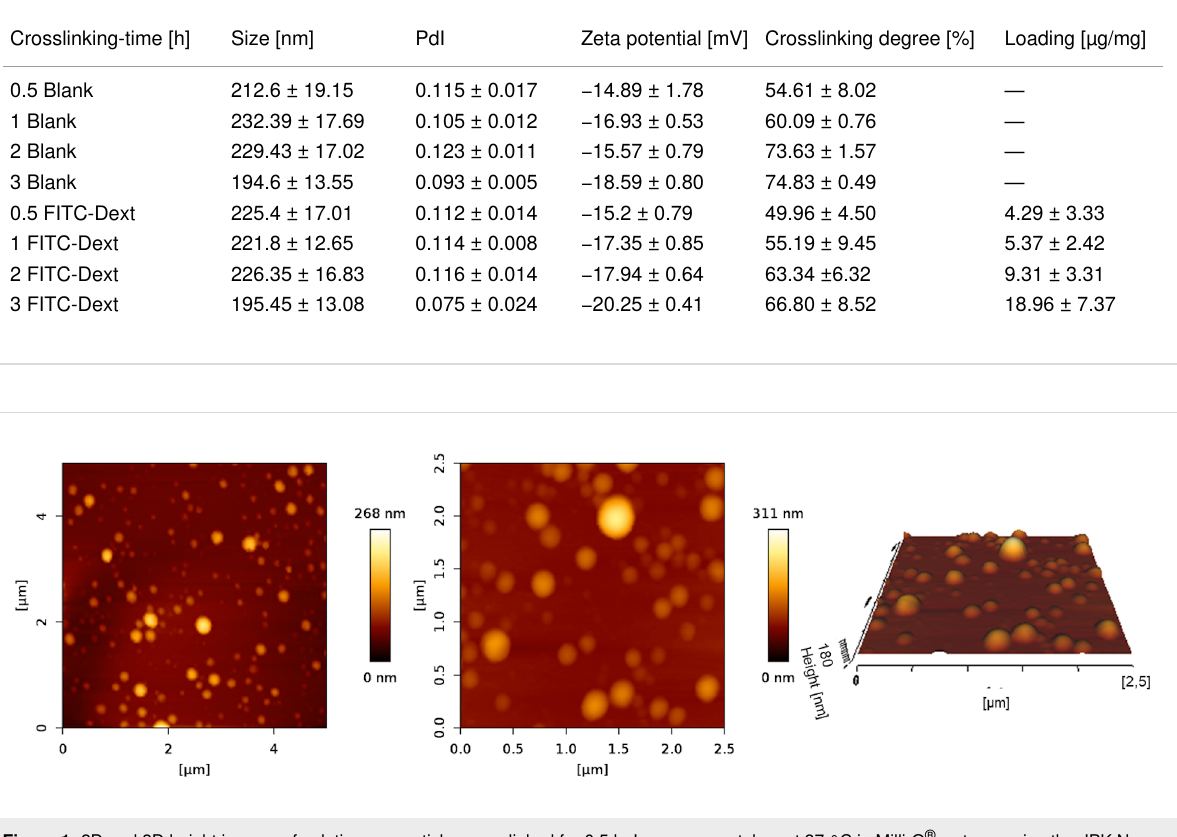
Figure 1: 2D and 3D height images of gelatin nanoparticles crosslinked for 0.5 h. Images were taken at 37 °C in Milli-Q ® water running the JPK Nano Wizard 3 AFM executing the QI™-Mode.